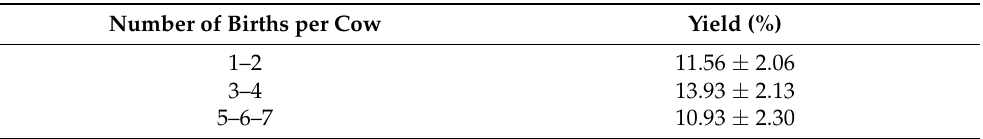
Figure 6. PRP yield considering the number of births. ( A ) Distribution (%) of cows in different PRP yield classes considering the number of births. ( B ) Comparison of PRP yield considering the number of births. Values are expressed as means and standard deviations. Different letters represent statistically significant differences. Table 3. Yield of PRP in cows with different numbers of births.